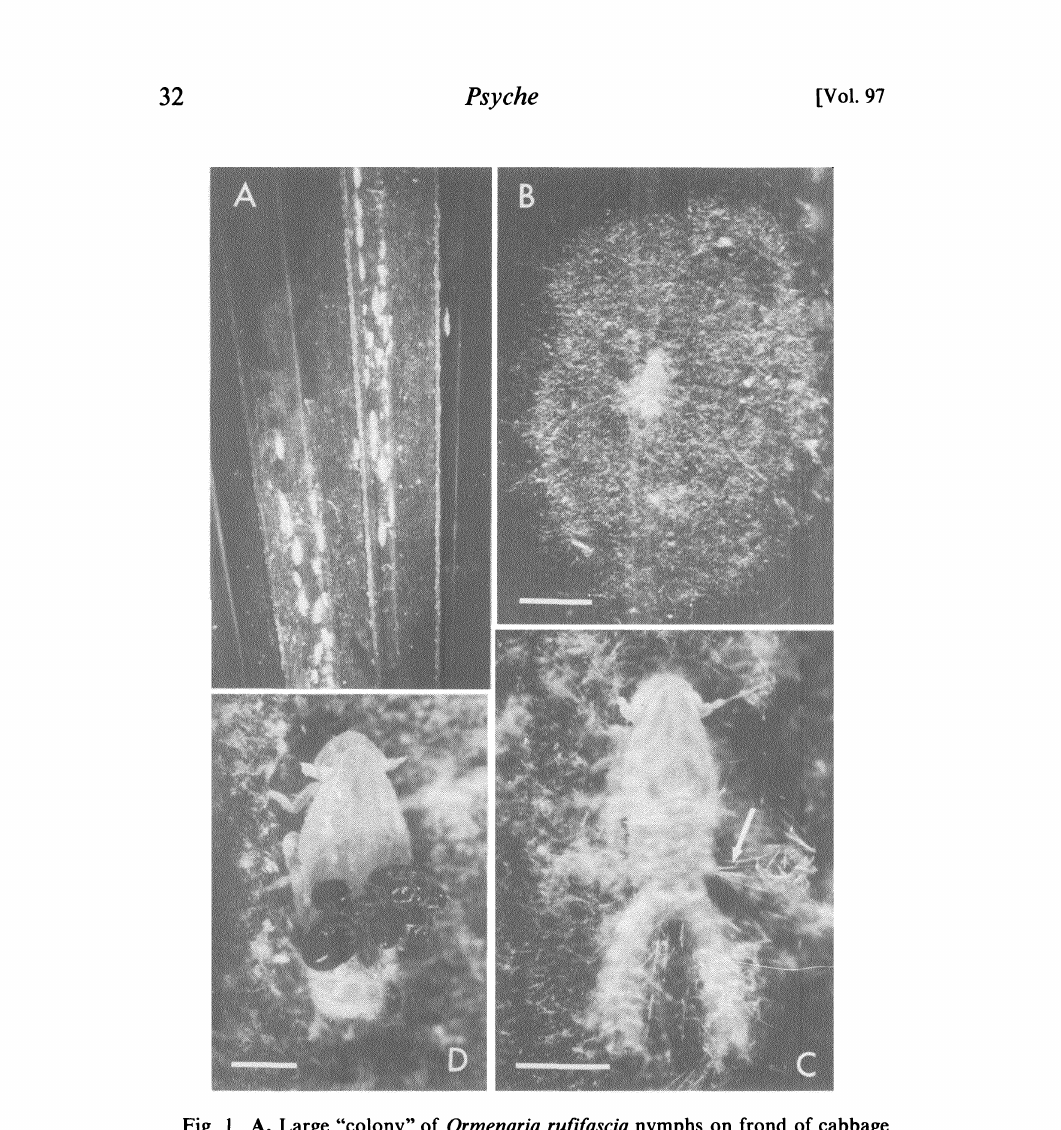
Fig. 1..4,, Large "colony" of Ormenaria rufifascia nymphs on frond of cabbage palm (Sabal palmetto); 27 nymphs are shown, of which 8 bore infesting mites (5 nymphs with mite; with 2 mites; with 3 mites; the infestations were resolved by microscopic examination of the original color transparency from which this photo- graph was made). B, Single nymph, on its wax pad. C, Nymph showing the two caudal and two lateral wax tufts (arrow denotes right lateral tuft). I, Late instar nymph bearing 9 Caeculisoma mites. Such high levels of infestation are exceptional. The individual shown died shortly after being photographed. Bars: B 5 mm; C, D 0.5